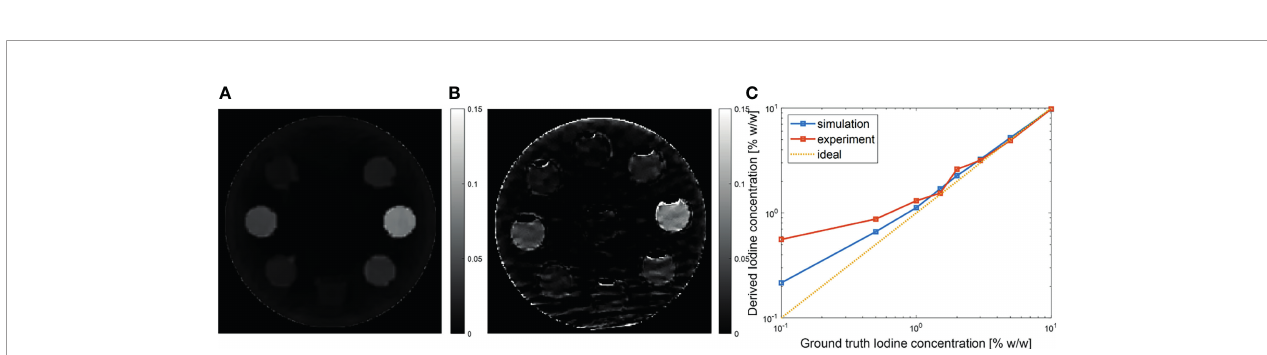
FIGURE 9 | (A, B) Iodine concentration images in simulation and experimental studies. (C) Derived iodine concentration as a function of ground truth value. Dashed diagonal line indicates the ideal situation.